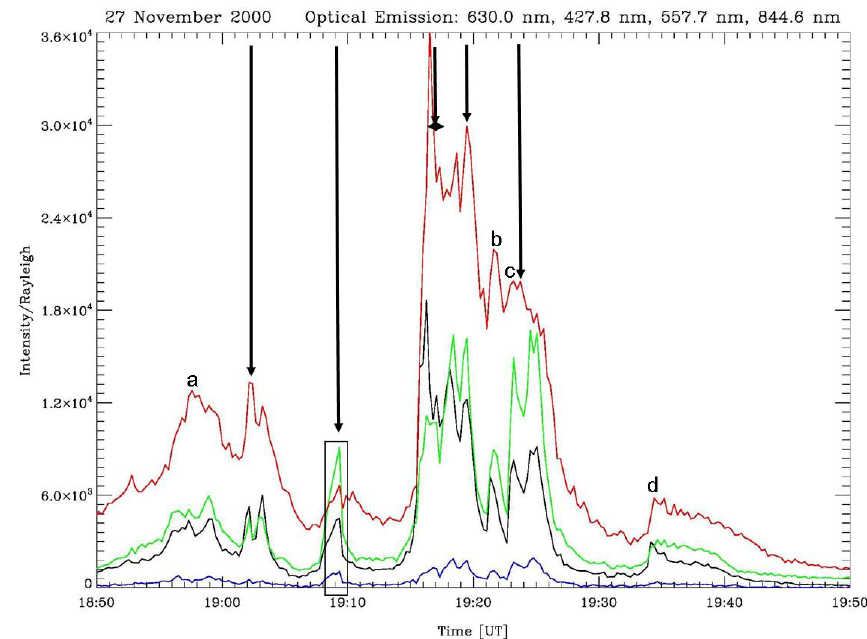
Fig. 7. Optical emissions corresponding to the field-aligned radar beam direction between 18:00–20:00UT and the MSP meridian scans have been smoothed by using a weighted triangular filtering of ± 1 ◦ . NEIAL events are marked with black arrows (and a black diamond), while the notation a, b, c and d shows emission peaks which do not correspond to such events. The enclosed frame is the event where the green line intensity exceeds the red line. The colour code is red, green, black and blue for the 630.0nm, 557.7nm, 844.6nm and 427.8nm lines, respectively.